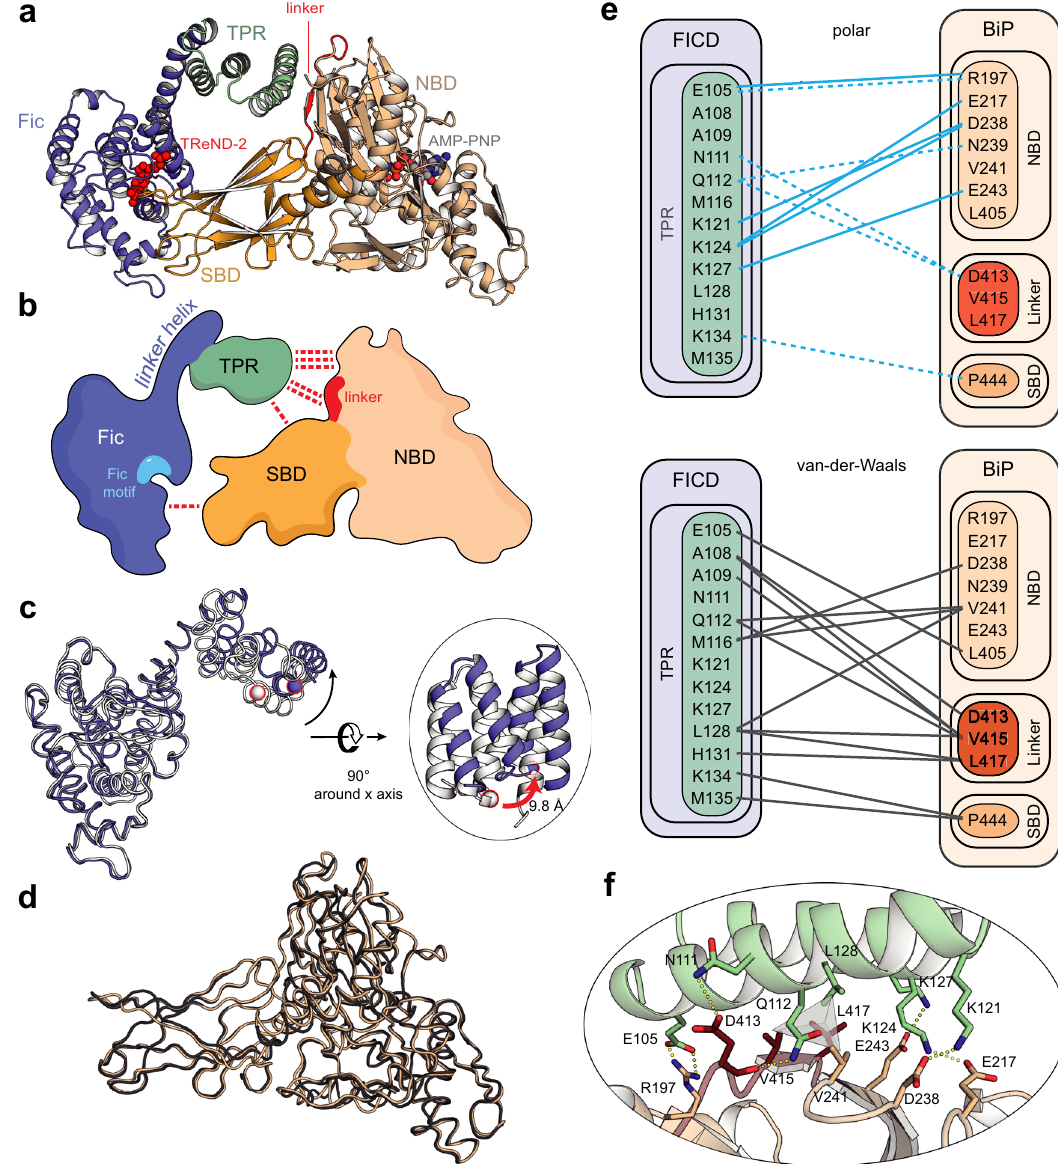
Fig. 2 Structure of the covalent complex of FICD and BiP. a Crystal structure of the covalently linked complex of FICD and BiP solved at 2.6 Å. FICD is represented in purple (Fic domain) and green (TPR motifs). BiP is colored in wheat (nucleotide-binding domain (NBD)) and orange (substrate-binding domain (SBD)). The conserved hydrophobic linker is highlighted in red. AMP-PNP is highlighted in light gray; TReND-2 is displayed in red. b Schematic overview of the complex. Colors are coded as in a . The Fic motif is highlighted in light blue and red dashed lines indicate speci fi c interactions. c Superimposition of complexed FICD (purple) with the isolated structure of FICD (white; PDB: 6I7G 31 ). Residues 104-434 were aligned. The movement of the TPR motifs is highlighted separately. The distance of C α of M135 FICD (red contoured spheres) from the complex and isolated FICD is calculated to be 9.8 Å. d Superimposition of BiP from the complex structure (wheat) with the isolated structure of BiP AMP (gray; PDB: 6EOF 20 ). e Schematic representation of all polar (top) and van der Waals (bottom) contacts between the TPR motif of FICD and BiP. Polar interactions are indicated in blue with solid lines representing salt bridges and dashed lines representing hydrogen bonds. Van der Waals contacts are displayed in gray. A conclusive representation of all identi fi ed speci fi c interactions between FICD and BiP is deposited in Supplementary Fig. 4. f Details of the molecular interactions of the N-terminal TPR motif of FICD with BiP. Interacting residues are highlighted and polar contacts are indicated as dashed lines in yellow. The central hydrophobic cluster is indicated by the gray pyramid. Colors are de fi ned as in a